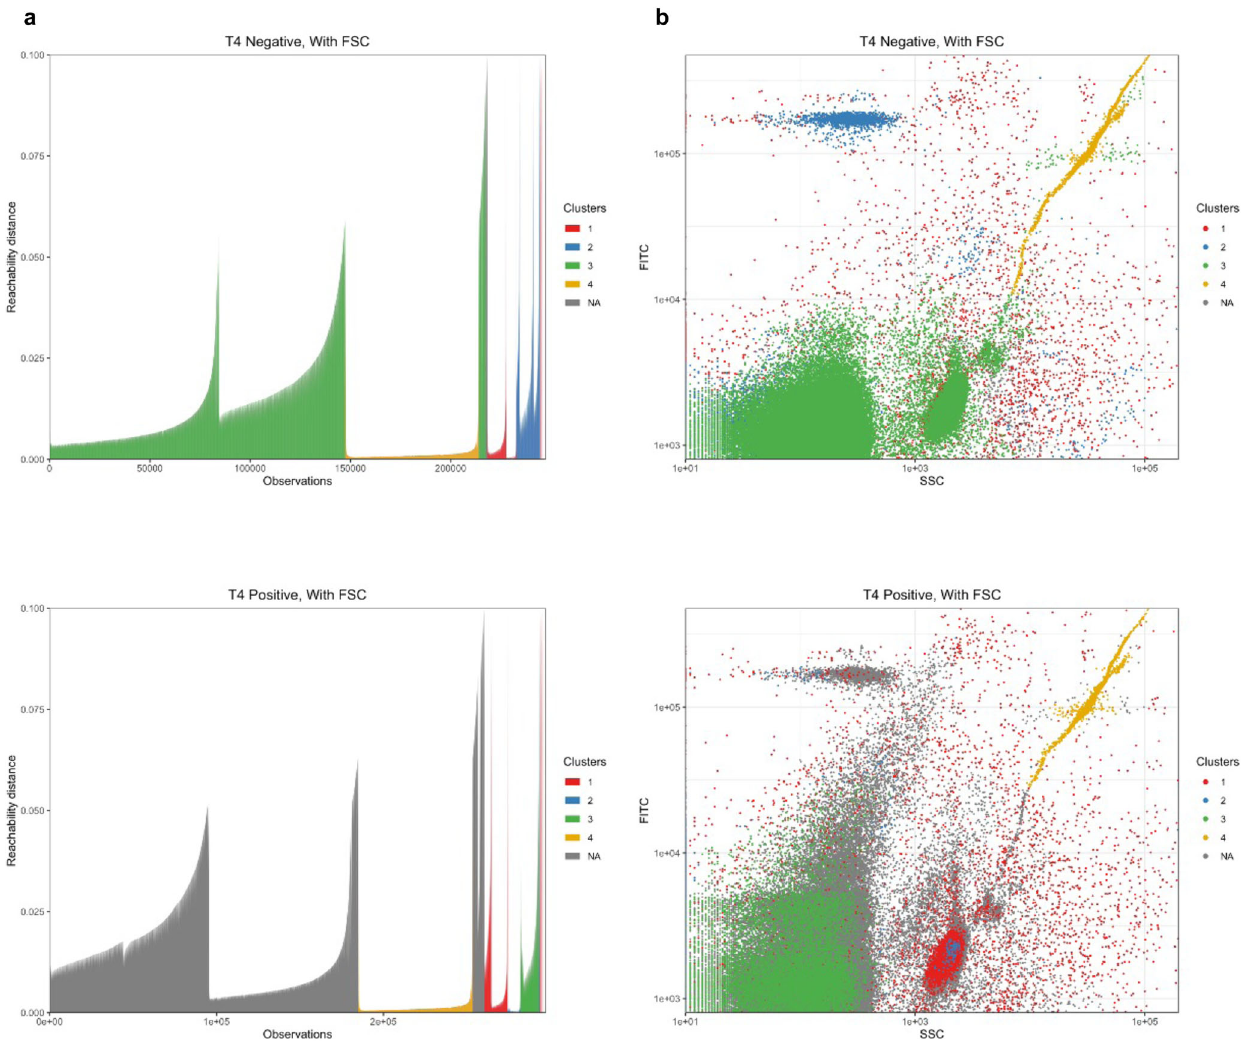
Fig. 9 Representative results of using the opticskxi algorithm to extract clusters from the same OPTICS-ordered data shown in Fig. 8. Panel a plots show the OPTICS ordering of the data from which the clusters were algorithmically extracted. Colors highlight each algorithmically extracted cluster. Panel b plots visualize the data as SSC vs. FITC plots, with points colored based on the cluster extraction. Cluster colors are consistent between the two plots for each of the T4-spiked and unspiked experiments, but not necessarily across experiments. Some clusters are not visually apparent on the scatterplots because they include low-SSC points collapsed onto the y